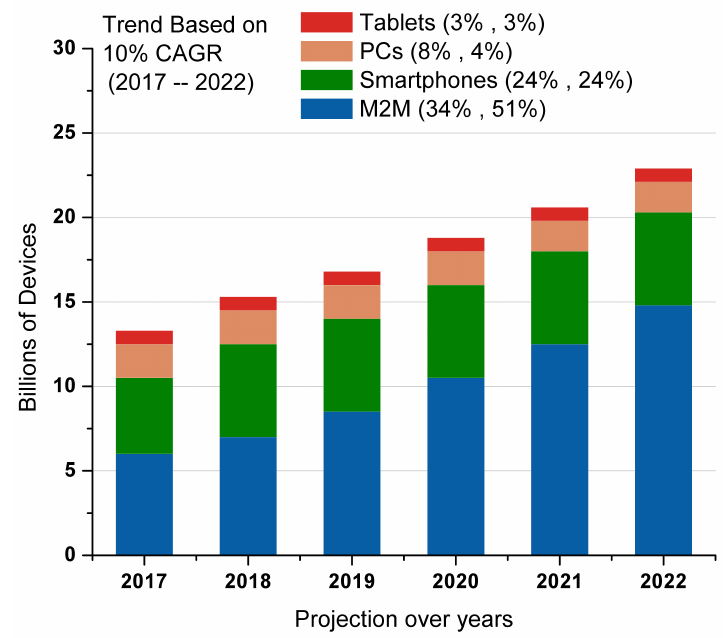
Figure 3. IoT traffic trends for M2M communication over next 5